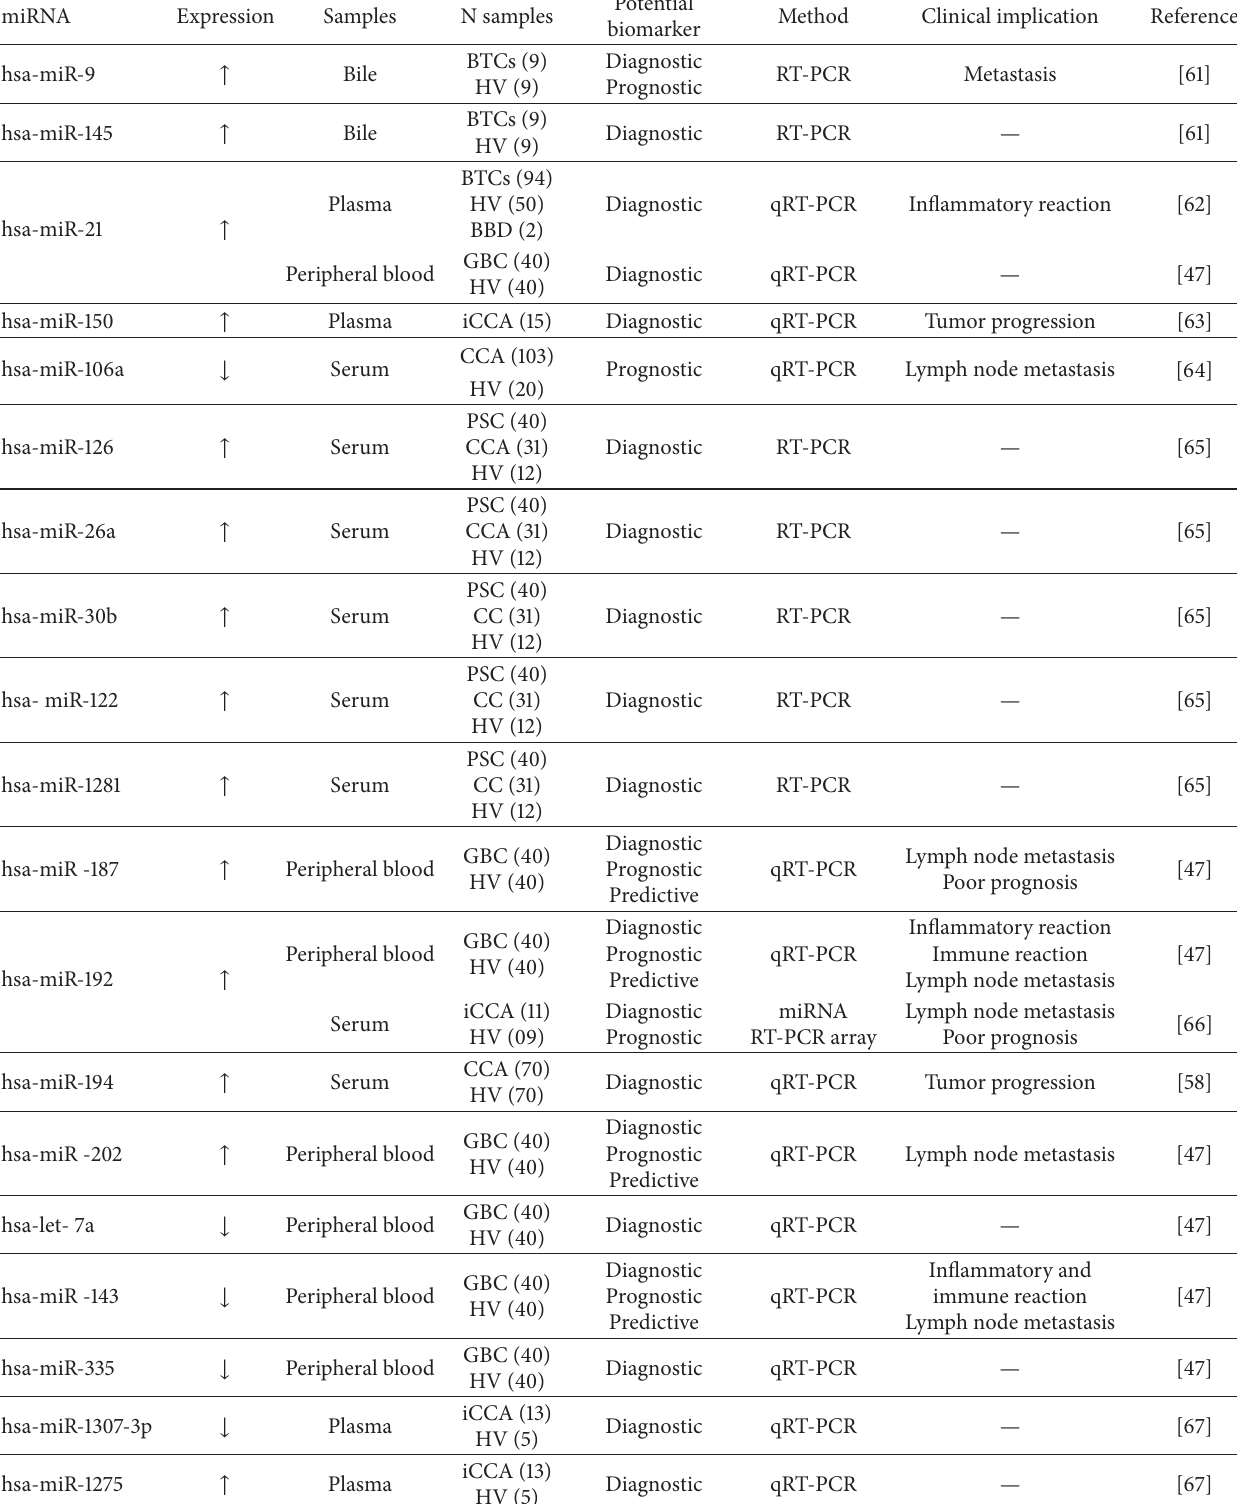
Table 2: Circulating miRNAs in patients with BTC as potential diagnostic, prognostic, and predictive biomarkers.